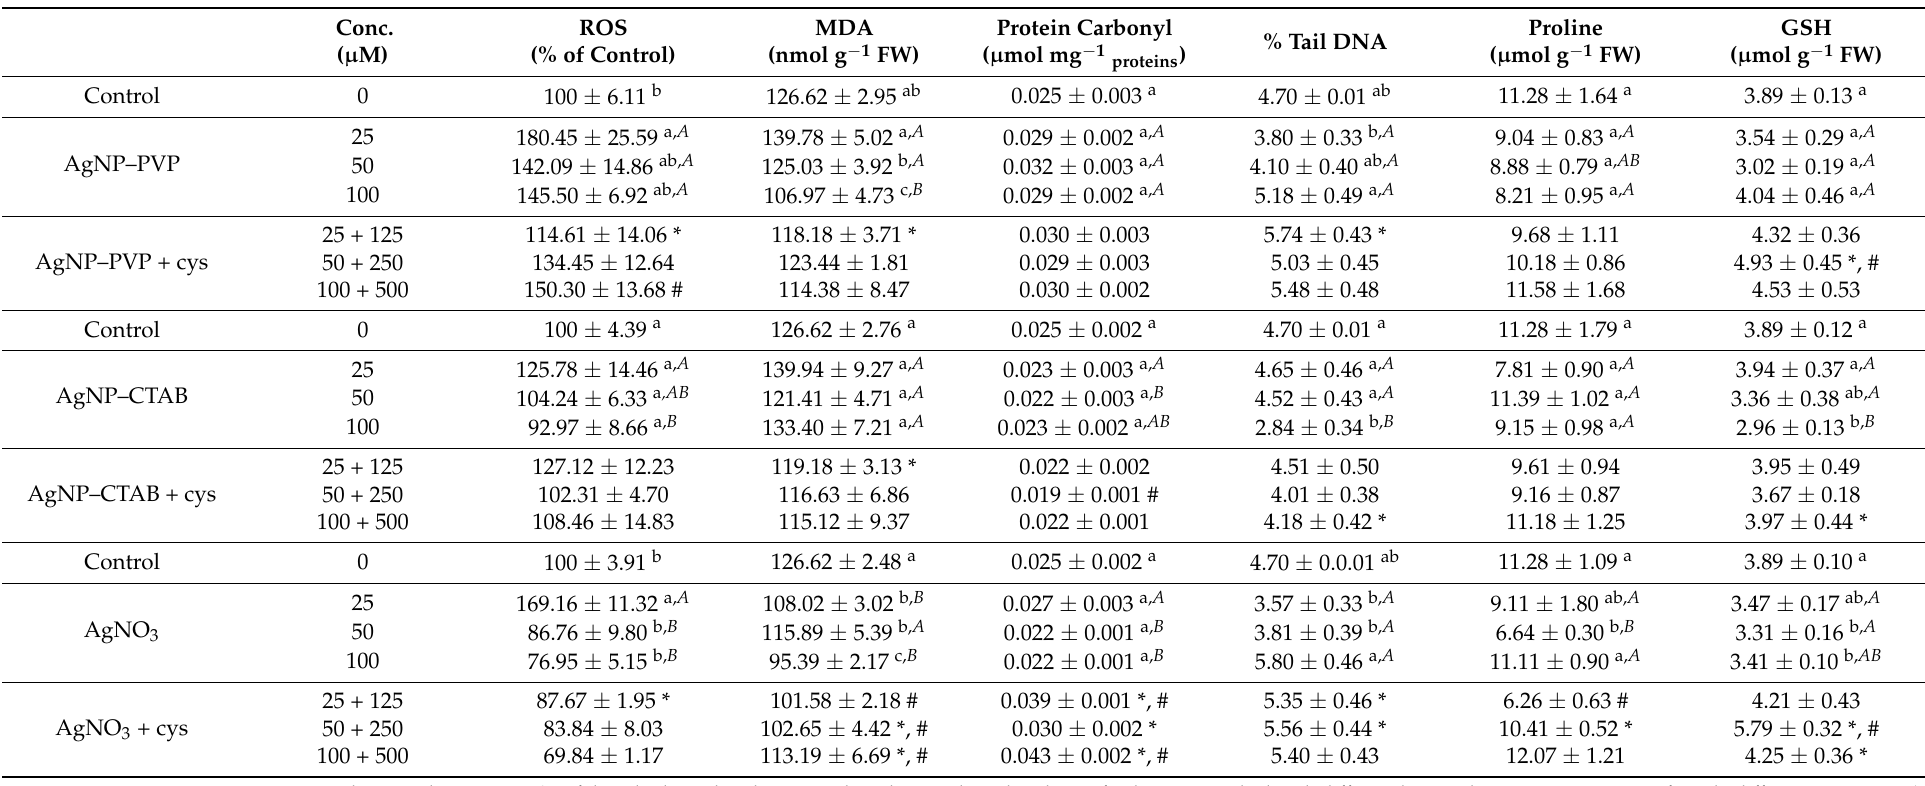
Table 2. Contents of reactive oxygen species (ROS), malondialdehyde (MDA), protein carbonyls, proline, reduced glutathione (GSH), and % tail DNA in roots